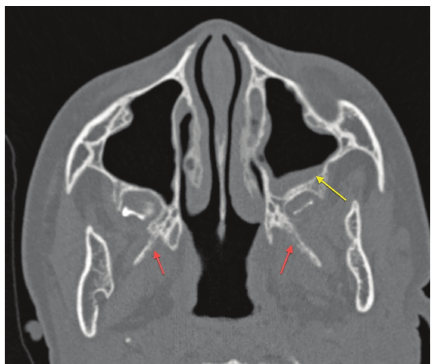
Figure 7: Axial CT: mucosal thickening of the left maxillary antrum is noted with mural bony thickening (yellow arrow). There are erosive changes involving the lateral pterygoid plates (red